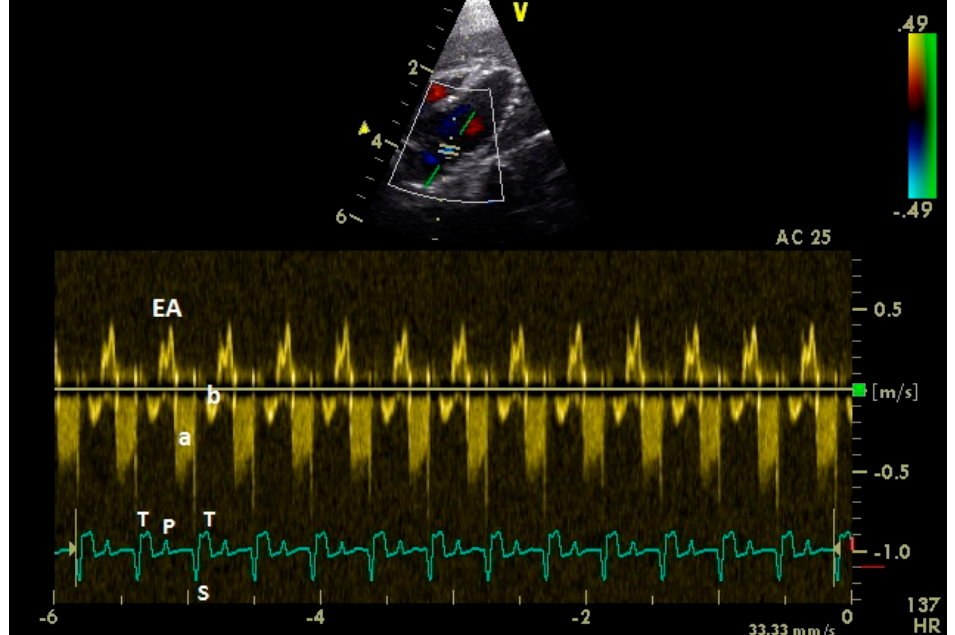
Figure 5. Pulsed-wave Doppler echocardiographic image of the left atrioventricular valve region of an anaesthetized healthy racing pigeon. Diastolic blood flow: EA: fused E and A wave. a: left atrioventricular insufficiency; b: part of systolic flow in left ventricle. Electrocardiogram: P: P wave; S: S wave; and T: T wave.